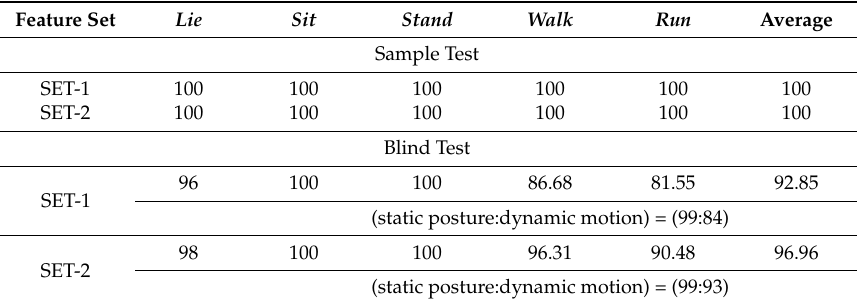
Table 3. Successful rate (%) of activity recognition by designed FIS.